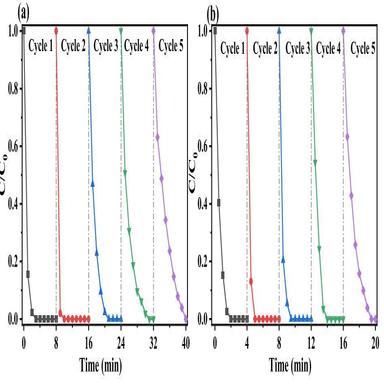
Recycling performances of 5%Cu2+-Co3O4/NC-glycerol-600 and 5%Cu-Co2AlO4/NC-glycerol-600 catalysts. Experimental conditions: 0= 0.36 g/L, 0= 1.3 mM, 0 = 12.5 mg/L, initial pH = 9, temperature = 25 ◦C.